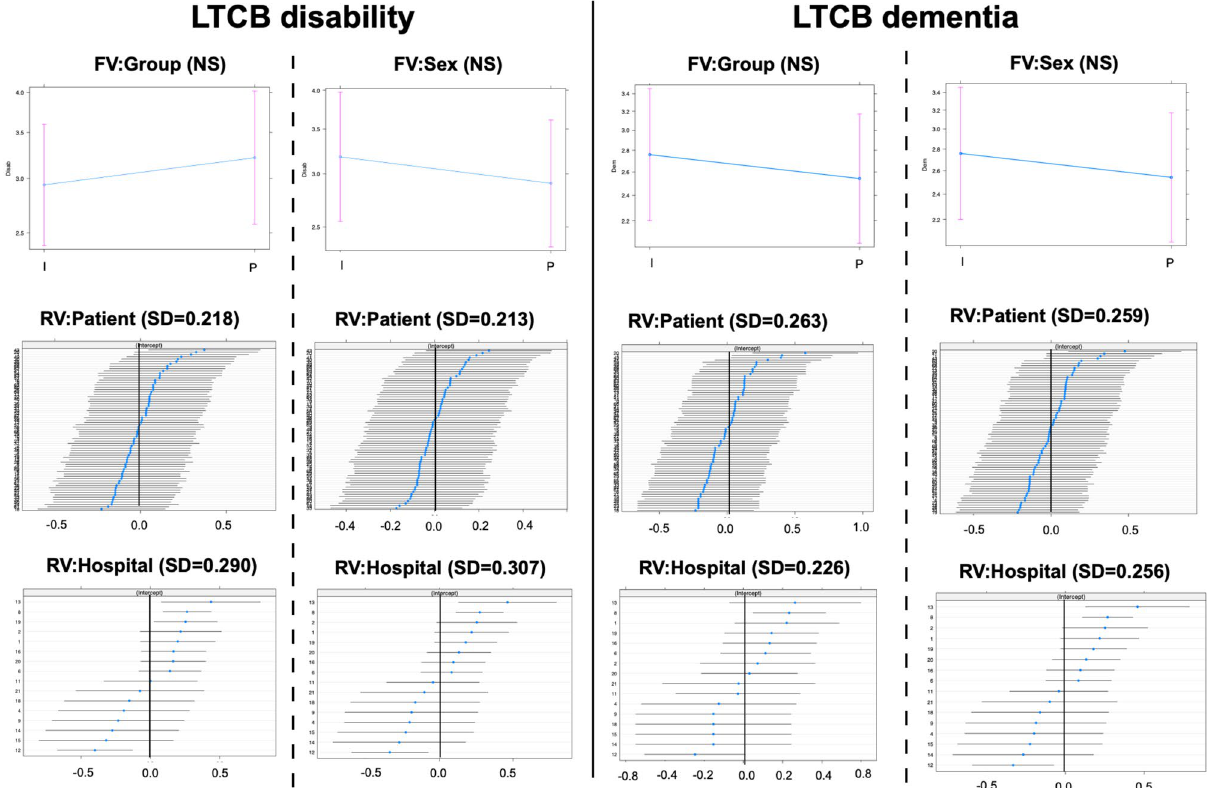
Figure 4. Changes in LTCB grades stratified by Group and Sex. There were no significant differences in LTCB grades (disability: left, dementia: right) between the IS and PS groups and between men and women. Confidence intervals of random variables (patient: middle, hospital: lower) showed that most patients were at zero and some specific hospitals were frequently below or above